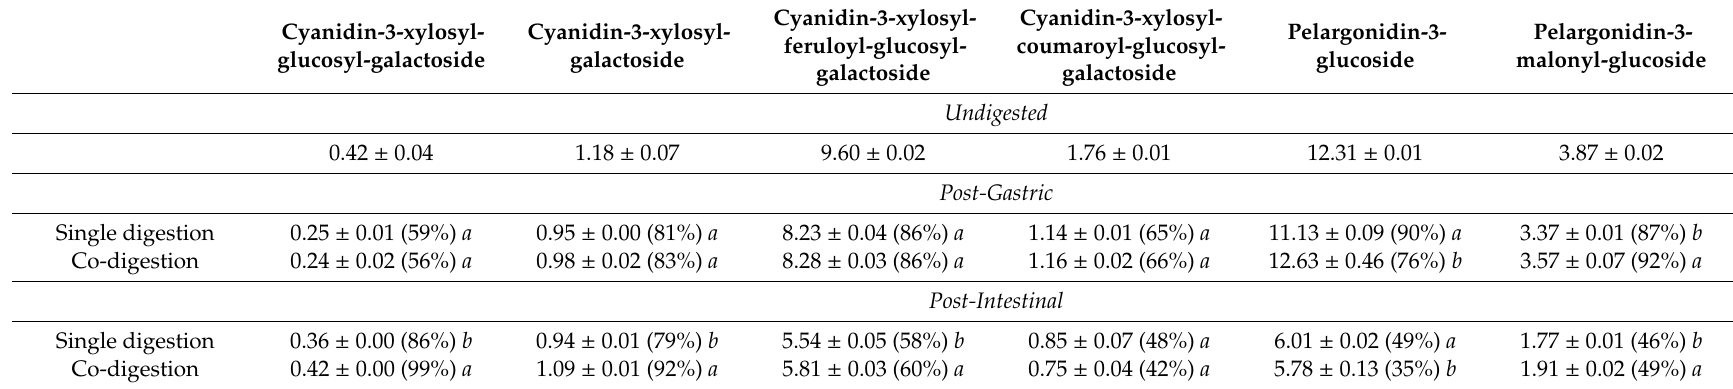
Table 2. E ff ect of co-digestion on gastric and intestinal stability of black carrot and strawberry anthocyanins, incubated as liquid extracts. Concentration expressed as mg / 100 mL of extract (mean ± SD) ( n = 3). Values in brackets represents the stability